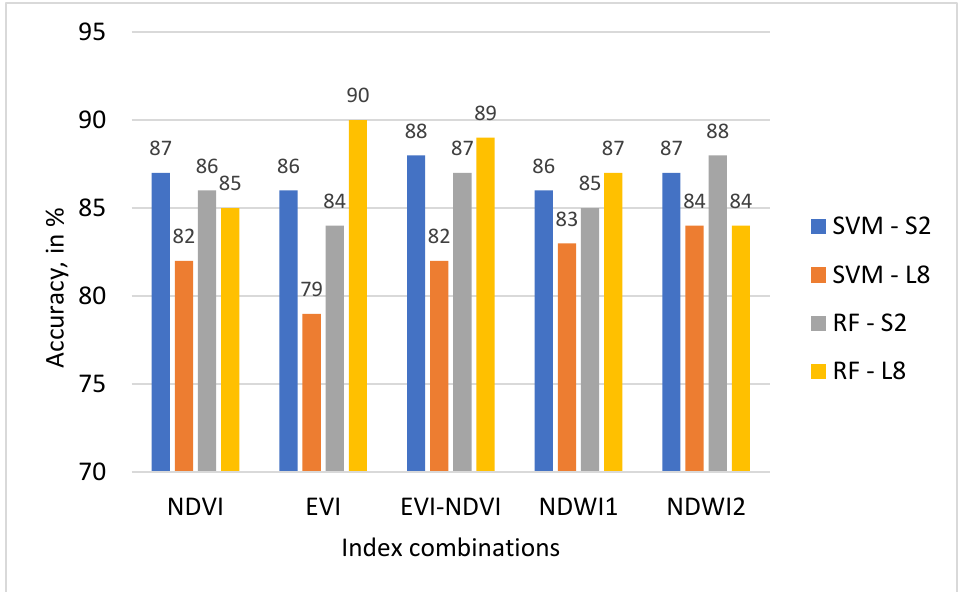
Figure 14. OA of SVM and RF classifiers on different indices and satellites.